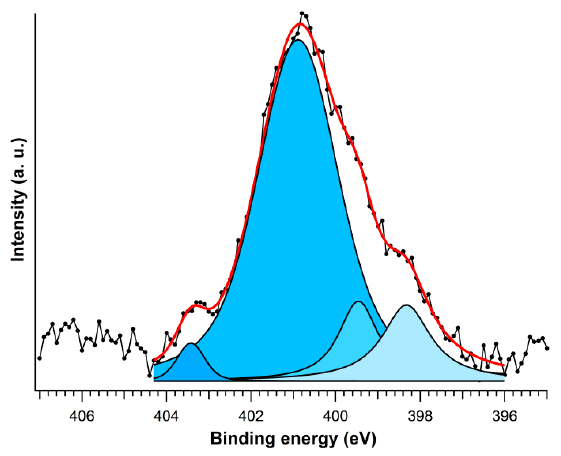
Figure 3. Deconvolution analysis of the XPS spectrum of the His-containing sample 3 .